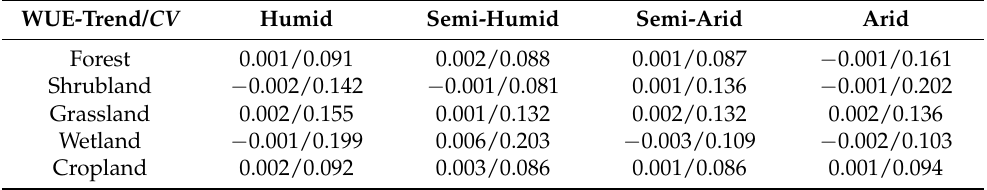
Table 2. Trends (units: gC · m − 2 · mm − 1 · yr − 1 ) and CV of WUE for each vegetation type in different arid-humid zones from 2001 to